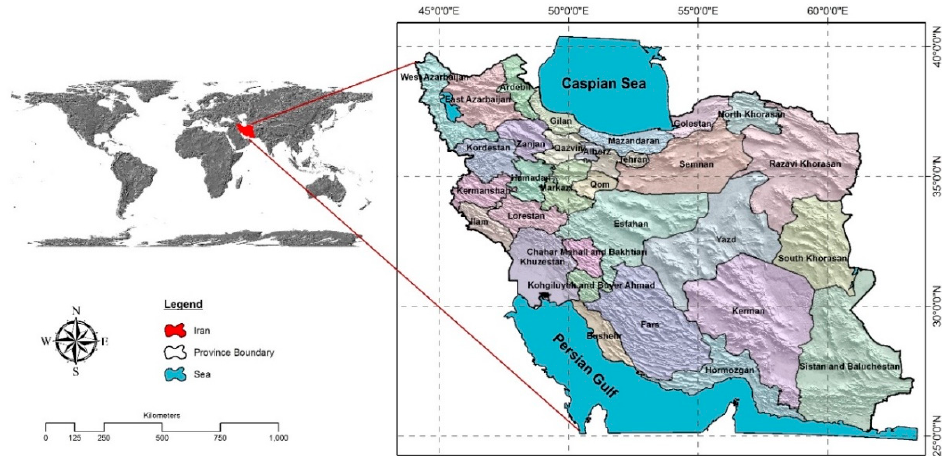
Figure 1. Map of Iran and its 31 provinces.